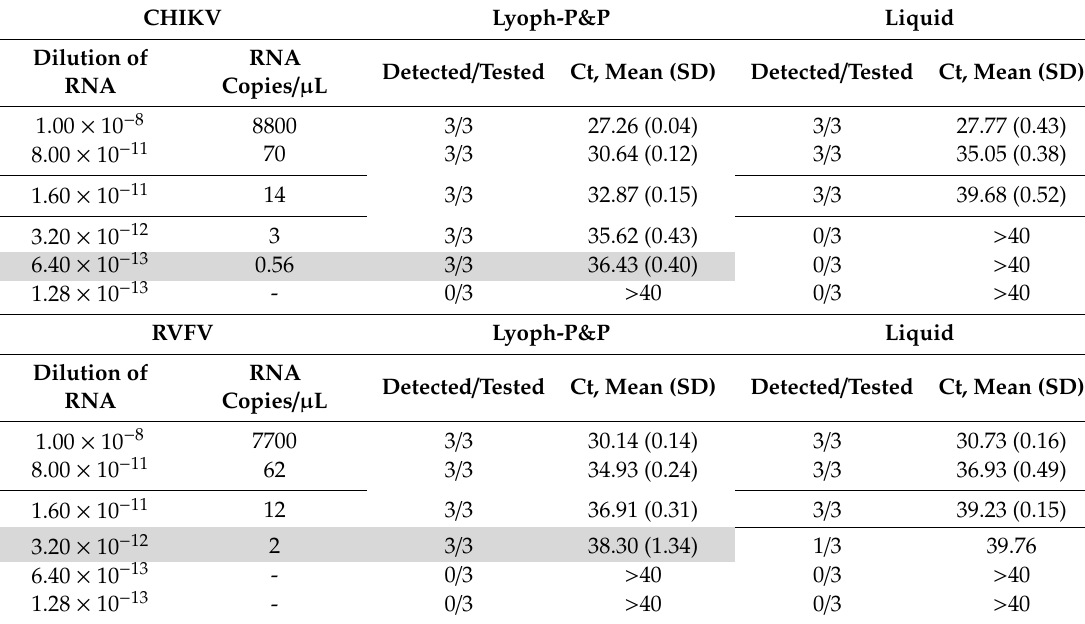
Table 7. Analytical sensitivity: comparison between Lyoph-P&P and extemporaneously prepared liquid formulation. CHIKV Lyoph-P&P Liquid Dilution of RNA Detected / Tested Ct, Mean (SD) Detected / Tested Ct, Mean (SD) RNA Copies / µ L